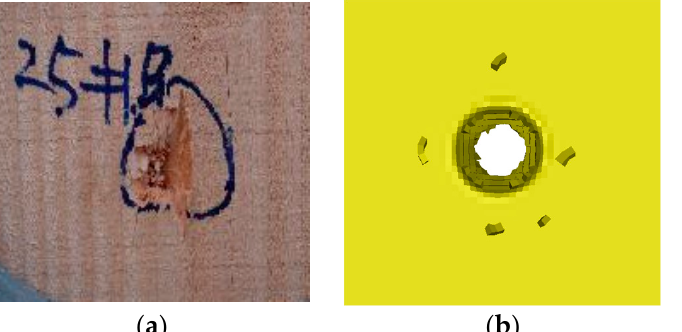
Figure 4. Comparison of experiment and simulation on the back of target plate. ( a ) is experiment;